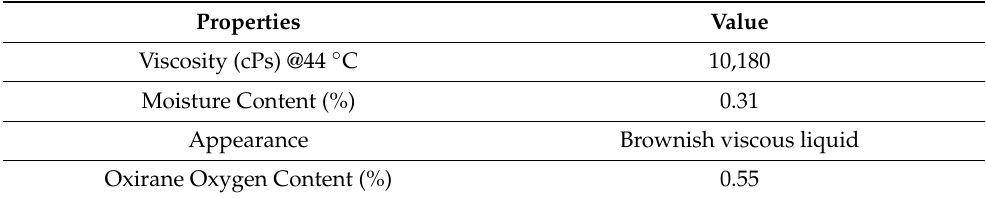
Table 2. Physicochemical Properties of the CSBO.